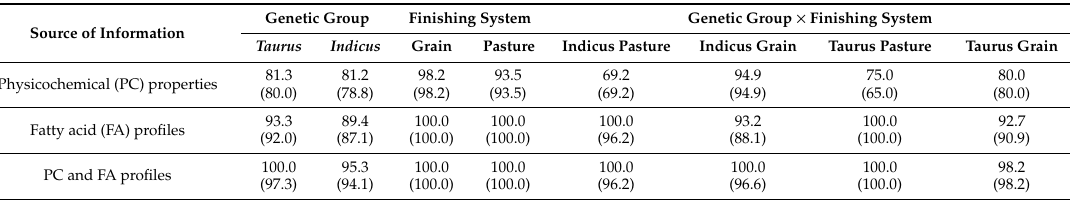
Figure 4. Graphical representation of the discriminant scores at the centroid of each genetic group × finishing system cluster according to three discriminant functions (DF1, DF2 and DF3, respectively) constructed based on physicochemical properties and fatty acid profiles, with indication of the most important variables involved in each discriminant function. — Taurus , pasture; — Taurus , grain; — Indicus , pasture; — Indicus , grain. (cid:35) Table 6. Percentage of correct allocations to genetic group, finishing system or combination of genetic group × finishing system, with discriminant functions based on meat physicochemical properties, fatty acid profiles or both. Values in ( ) correspond to crossvalidation results, where each observation is assessed after being removed from the data set to compute a discriminant